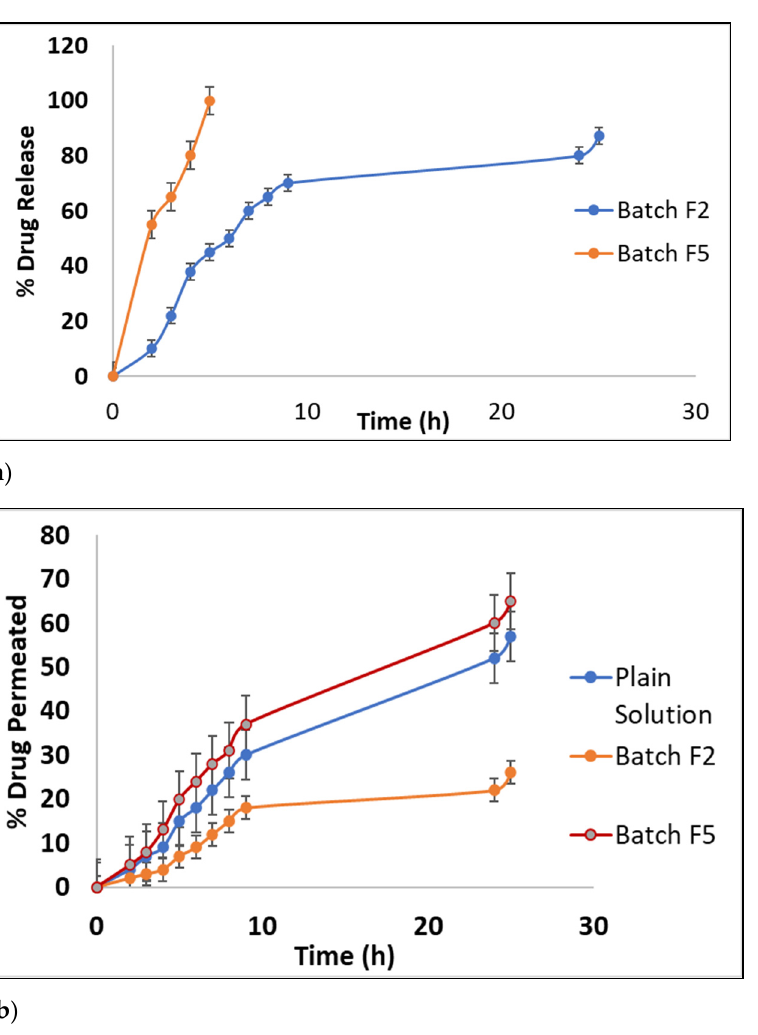
Figure 6. ( a ) The drug release profile from tablets formulated with PM (batch F2) and TRM (batch F5). ( b ) Permeation studies of drug through tablets formulated with PM (batch F2) and TRM (batch F5) compared to plain drug solution.